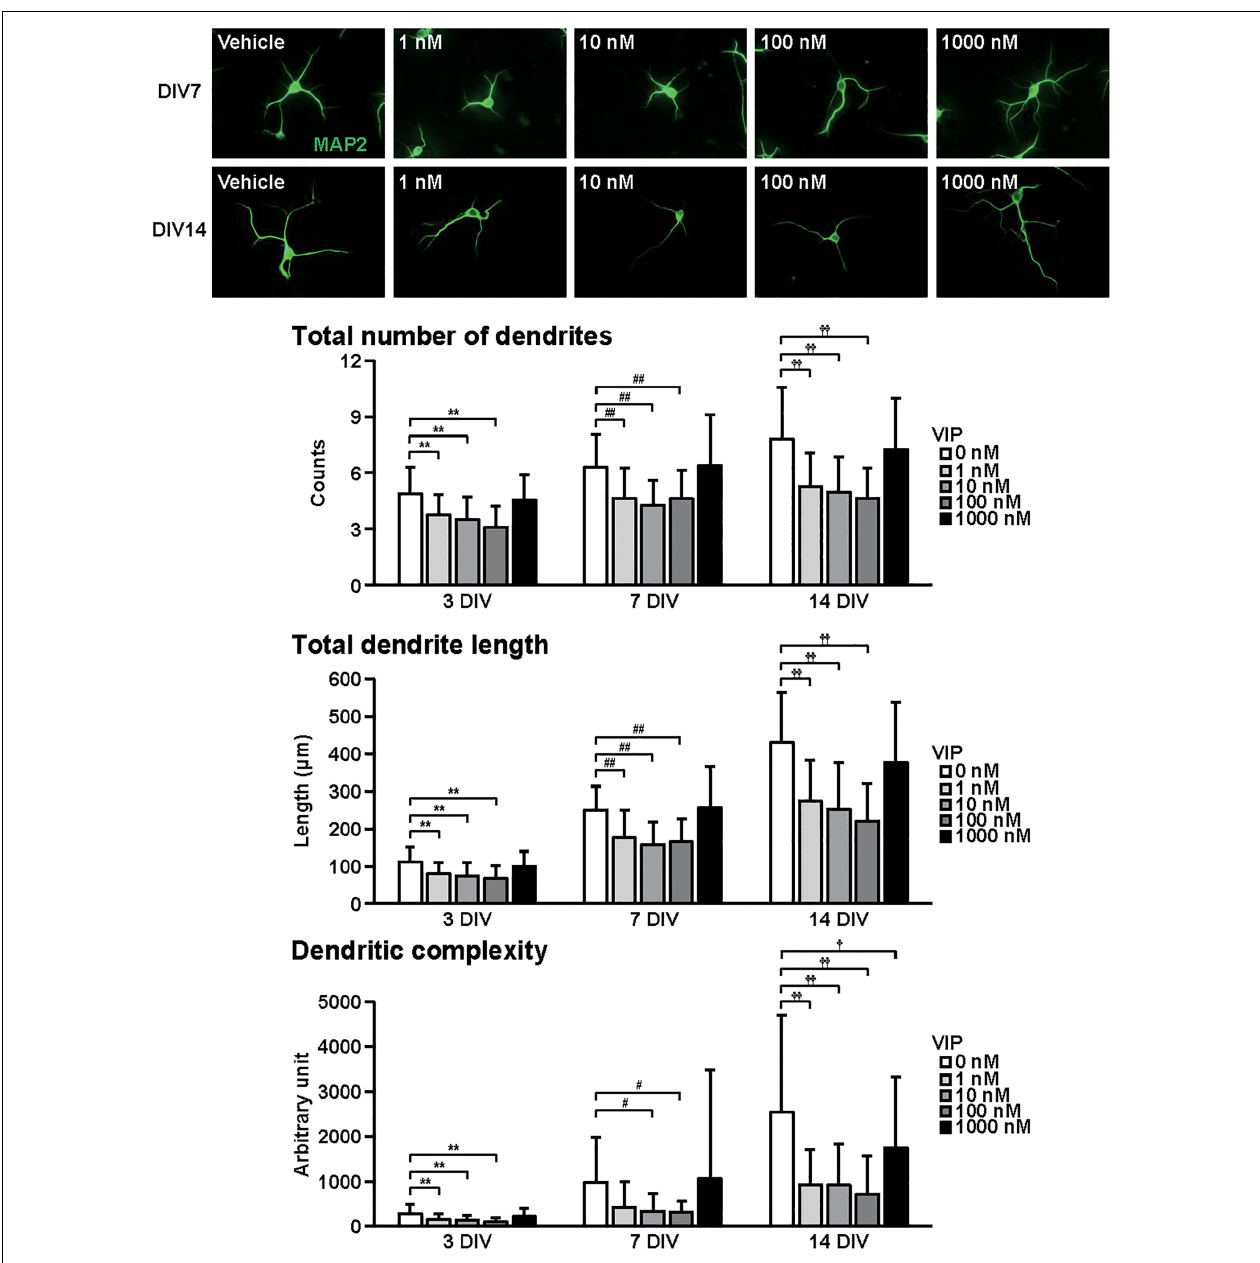
FIGURE 2 | Effects of VIP on dendritic outgrowth in cultured cortical neurons. Representative MAP2 (green)-immunostained images of neurons cultured with VIP (1–1000 nM) for 7 to 14 days in vitro (DIV) are shown. Quantitative analysis of dendritic morphology at 3 ( Figure 1B ), 7, and 14 DIV revealed that VIP significantly decreased the total numbers (main effects: F 2 , 805 = 75.487, P < 0.0001 for time, F 4 , 805 = 52.424, P < 0.0001 for treatment; interaction: F 8 , 805 = 2.556, P < 0.01) and length (main effects: F 2 , 805 = 374.760, P < 0.0001 for time, F 4 , 805 = 51.272, P < 0.0001 for treatment; interaction: F 8 , 805 = 8.563, P < 0.0001) of dendrites, and dendritic complexity (main effects: F 2 , 805 = 76.423, P < 0.0001 for time, F 4 , 805 = 20.616, P < 0.0001 for treatment; interaction: F 8 , 805 = 5.856, P < 0.0001). Values represent mean ± SD of 40–60 neurons from three independent experiments. ** P < 0.01, # P < 0.05, ## P < 0.01, † P < 0.05, †† P < 0.01 vs.